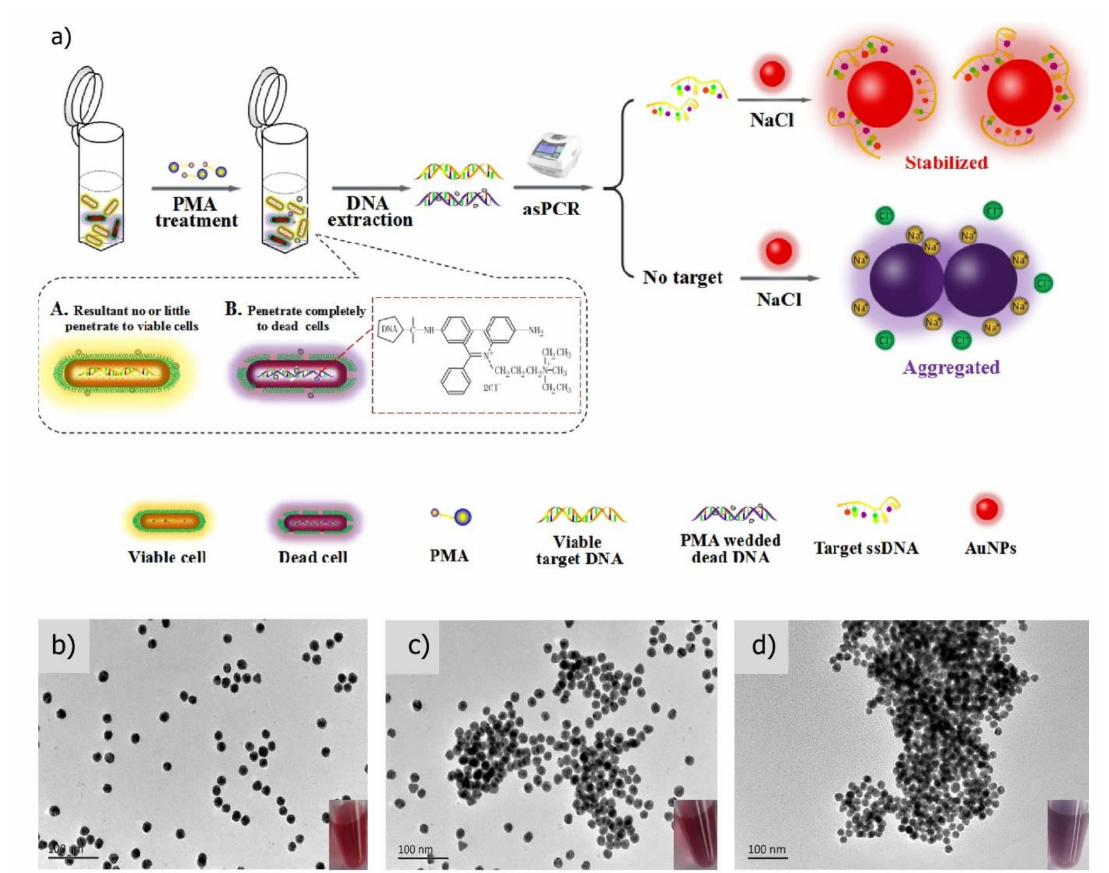
Figure 2. Schematic illustration of the colorimetric method based on PMA-asPCR ( a ) and visualization of gold nanoparticles for the detection of viable emetic B. cereus . Transmission electron microscope images correspond to ( b ) AuNPs alone, ( c ) AuNPs treated with 1 pmol ssDNA and 25 mM NaCl, and ( d ) AuNPs upon the addition of 25 mM NaCl without ssDNA. Insets show the respective images. (Reprinted with Permission from